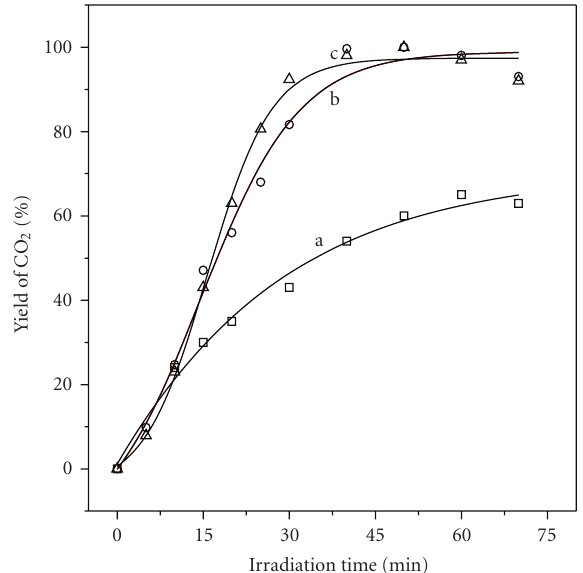
Figure 9: Yield of CO 2 as a function of UV-radiation dose during the vapor-phase photo-oxidation of acetone, (3.2–3.5 mol% in air) at room temperature over impregnation-prepared Au/TiO 2 samples I1(curve (a)), I2 (curve (b)), and I3 (curve (c)).